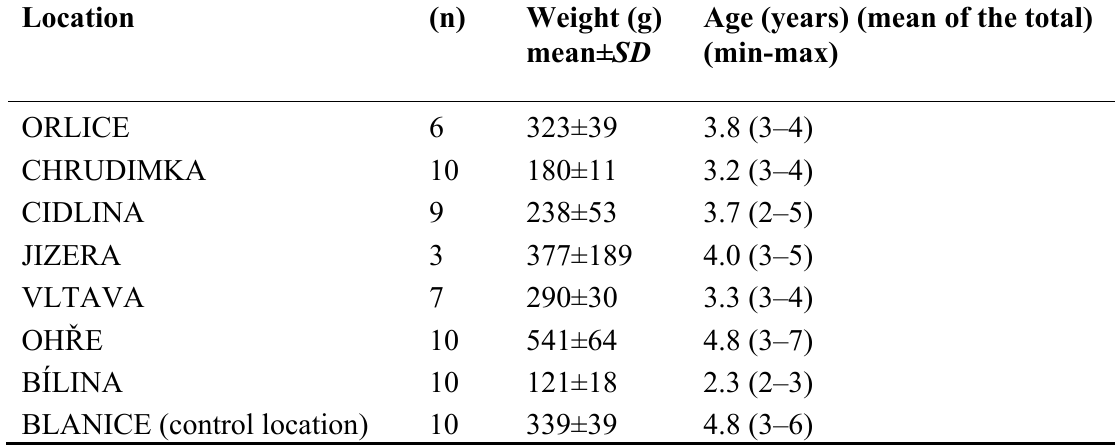
Table 1. Biometric characteristics of male chub ( Leuciscus cephalus L.), n = number of fish